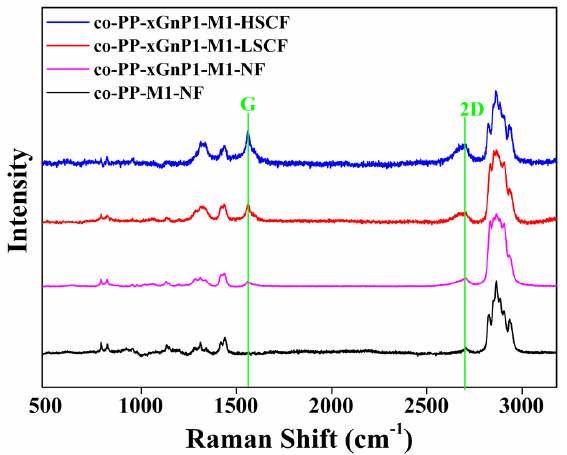
Figure 10. Raman spectrum of nanocomposite with 1 wt % xGnP prepared by Method 1. xGnP: graphene nanoplatelet.